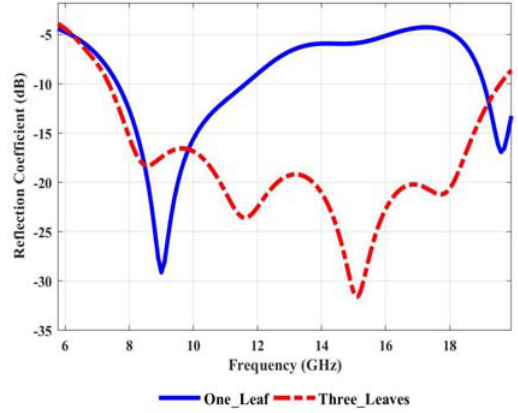
Fig. 3. Comparison of the simulated reflection coefficient between antenna with one ellipse and with three ellipses.